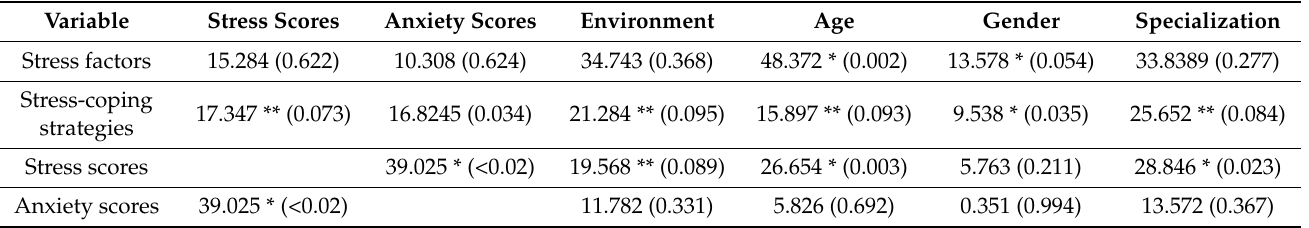
Table 2. The correlation between the stress factors and the strategy for coping with stress and anxiety. Variable Stress Scores Anxiety Scores Environment Age Gender